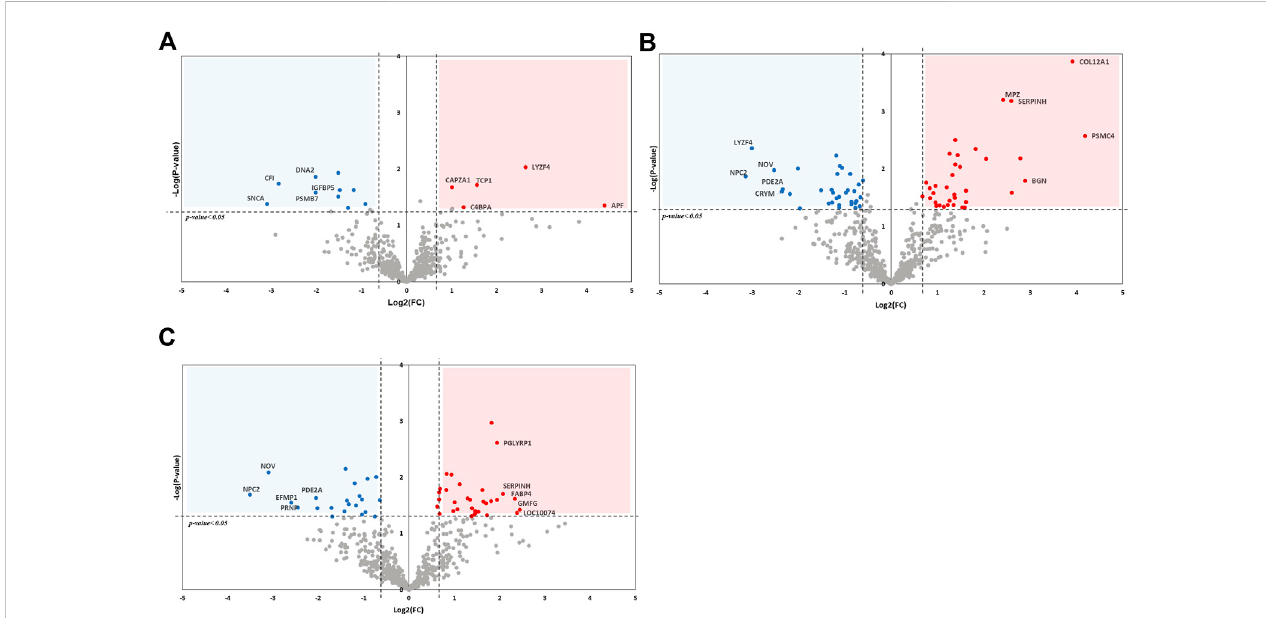
Volcano plot of DEPs after comparison between each group by t-test analysis. The x-axis of plot presented logarithmic value (log2) of fold-change between two comparing groups and dashed line indicates fold change greater than 1.5 and lower than − 1.5. The p -value after t -test analysis were presented on y-axis and p -value lower than 0.05 is marked as dashed line. (A) DEPs comparedwith control and saline treated group. (B) DEPs compared between saline and DVV treated group. (C) DEPs compared between control and DVV treated